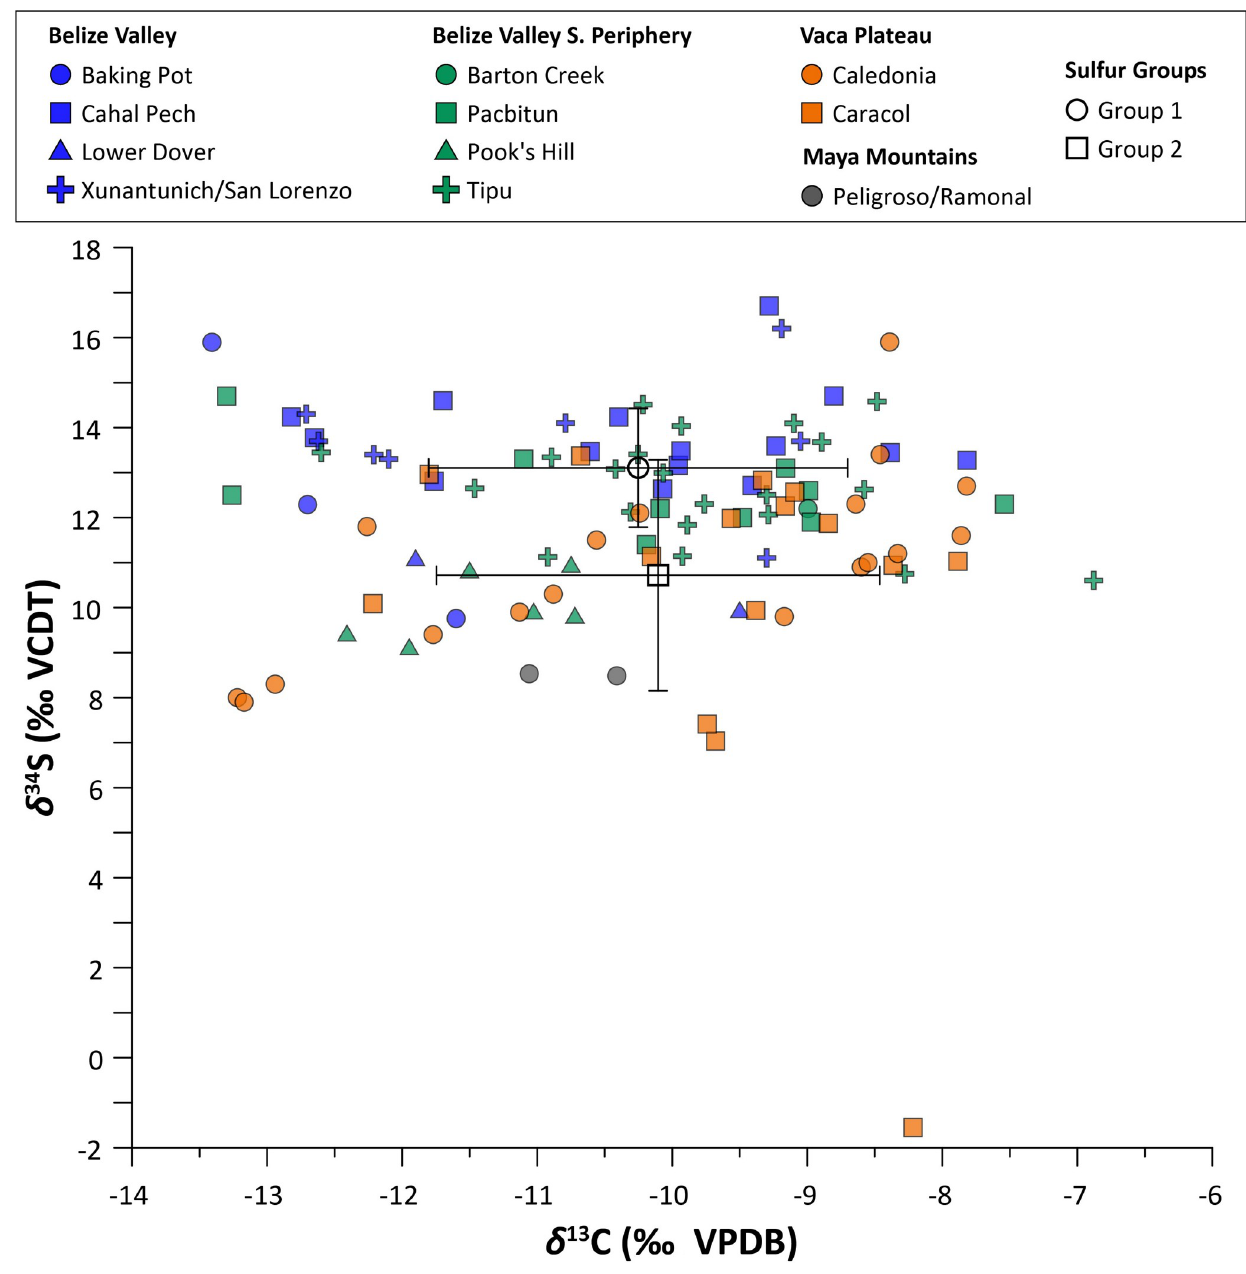
Fig 6. Eastern lowland human δ 13 C and δ 34 S values plotted by geographic zone. Open symbols and error bars indicate the mean and standard deviation of δ 34 S values in each sulfur group. however, are likely the results of sampling bias as they correlate with the predominant geo- graphic zones represented by our sulfur isoscape model in each time period (see [S3 Text]). Multivariate statistical analyses indicate weak relationships between δ 13 C and δ 34 S values and between δ 15 N and δ 34 S values at the regional level, as well as at the site level (Figs 6 and 7; see also [S3 Text]). The exception is the site of Caledonia, where there was a strong positive correlation between δ 13 C and δ 34 S values ( n = 18; r = 0.703, p < 0.001; r = 0.681, p < 0.05). s